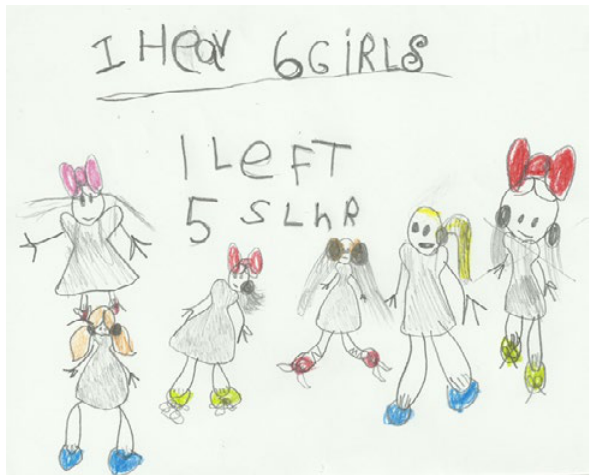
Figure 3: Math story of a five-year-old: “I have 6 girls, 1 left, 5 still here.”